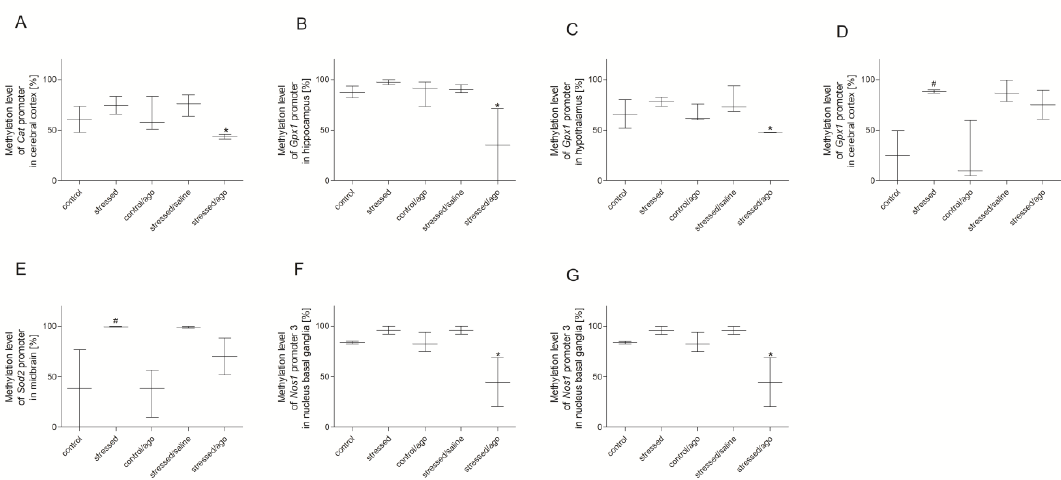
Figure 3. The methylation status Gpx4 promoter 3 ( A ), NOS1 promoter 3 ( B ), in PBMCs of animals exposed to CMS procedure for two weeks (Control, Stressed) and in animals exposed to CMS procedure for seven weeks and administered vehicle (1 mL/kg) or agomelatine (10 mg/kg) for five weeks (Control/Ago, Stressed/Saline, Stressed/Ago). Data presented as means ± SEM. N = 6. ** p < 0.01 for differences between stressed and stressed/ago groups, and # p < 0.05 for differences between controls and stressed groups.